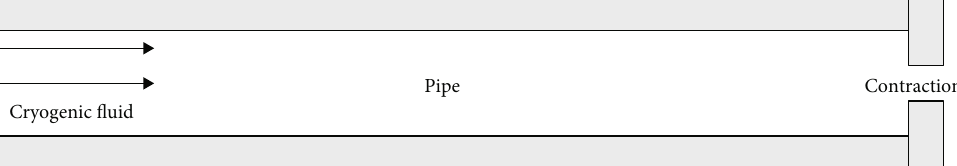
Figure 3: Pipe with a contraction on the